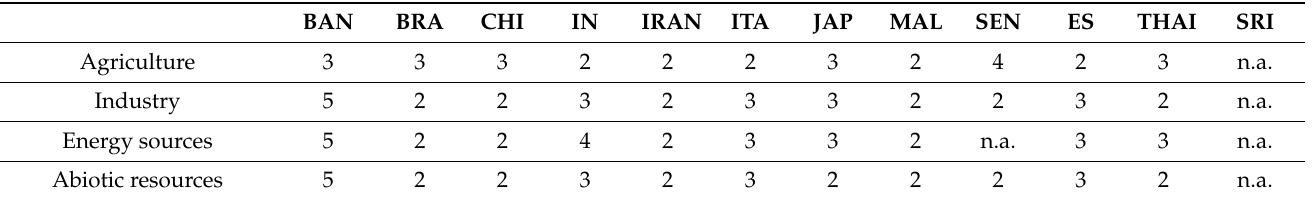
Table 2. Working hours: Risk of improper working hours (score 1 = very low risk, 5 = very high risk, n.a. = not available)